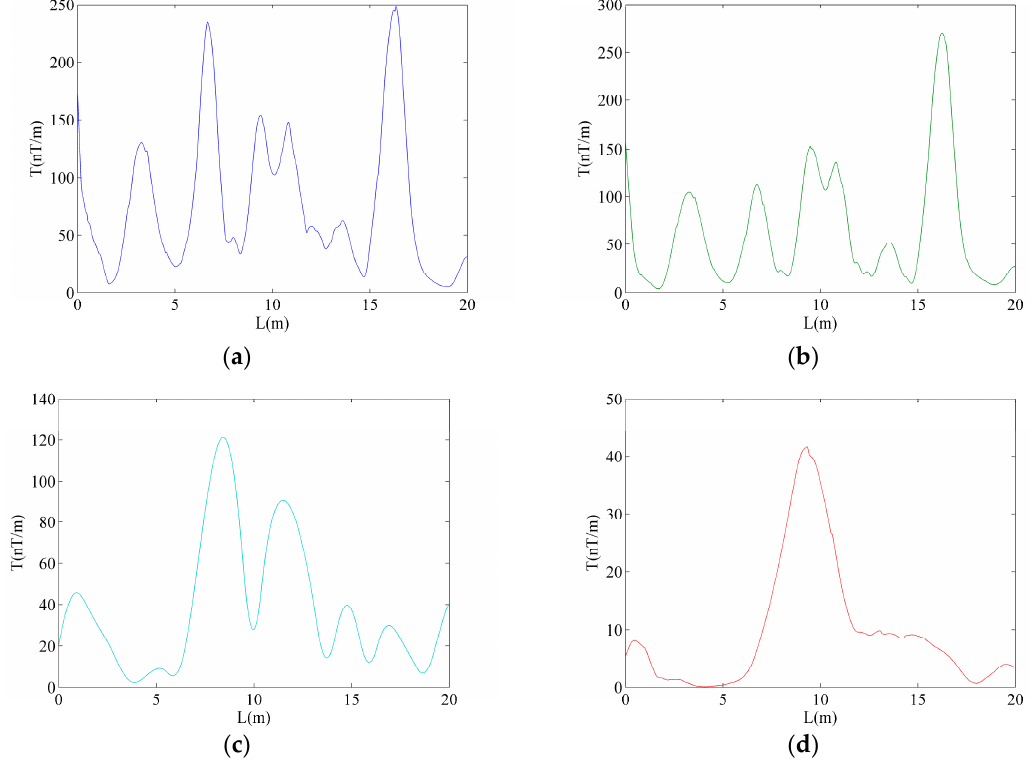
Figure 12. The four detection results of field testing. ( a ) Conventional CEEMDAN denoising 1-TEO.